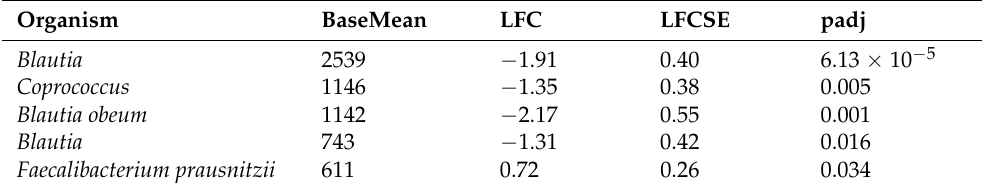
Figure 2. Ordination analysis of HLA-B27 positive (blue) versus negative (red) subjects. NMDS = nonmetric multidimensional scaling. Table 3. Statistically significant results of the DeSeq2 output comparing HLA-B27+ to negative off- spring. The full dataset is shown as Supplemental data. Abbreviations: LFC, log2Fold change; LFCSE, log2Fold change standard error; padj, adjusted (corrected) p -value. LFC values > 0 represent OTUs higher in HLA-B27+ subjects.